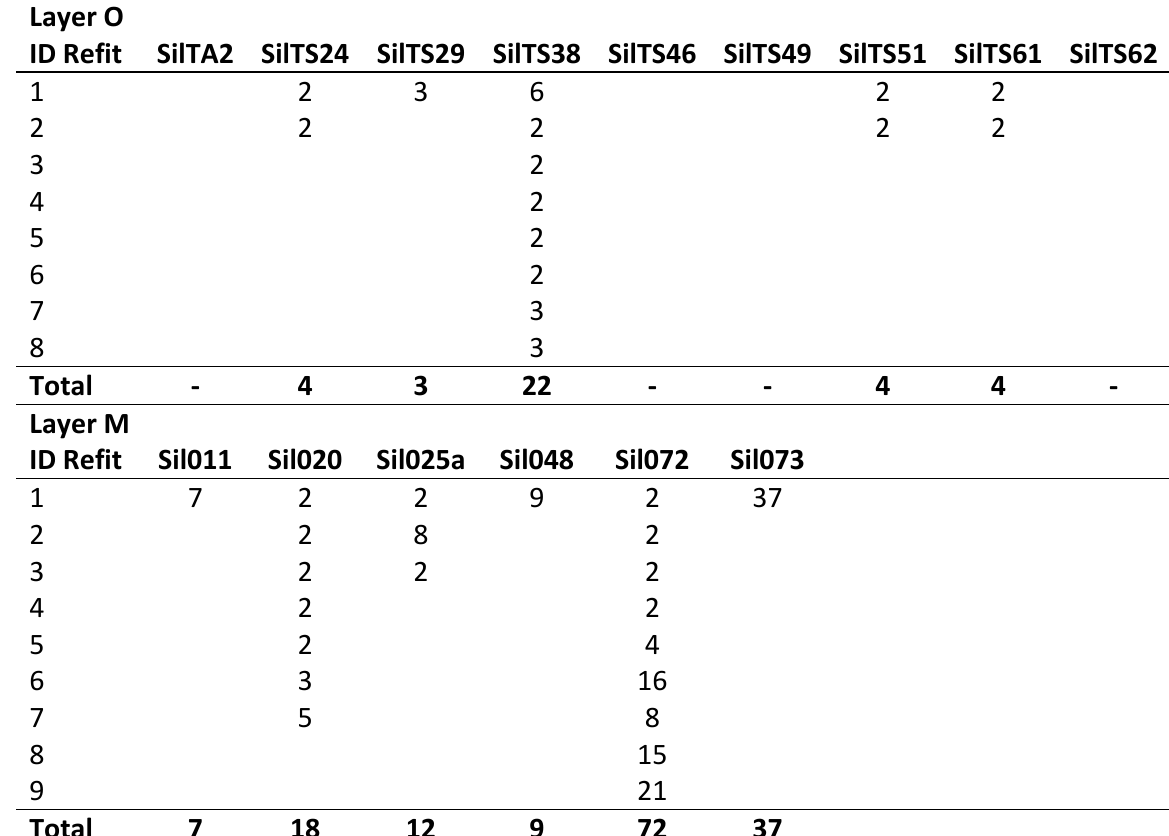
Table 5. Layers O and M, number of elements refitted in the RMUs